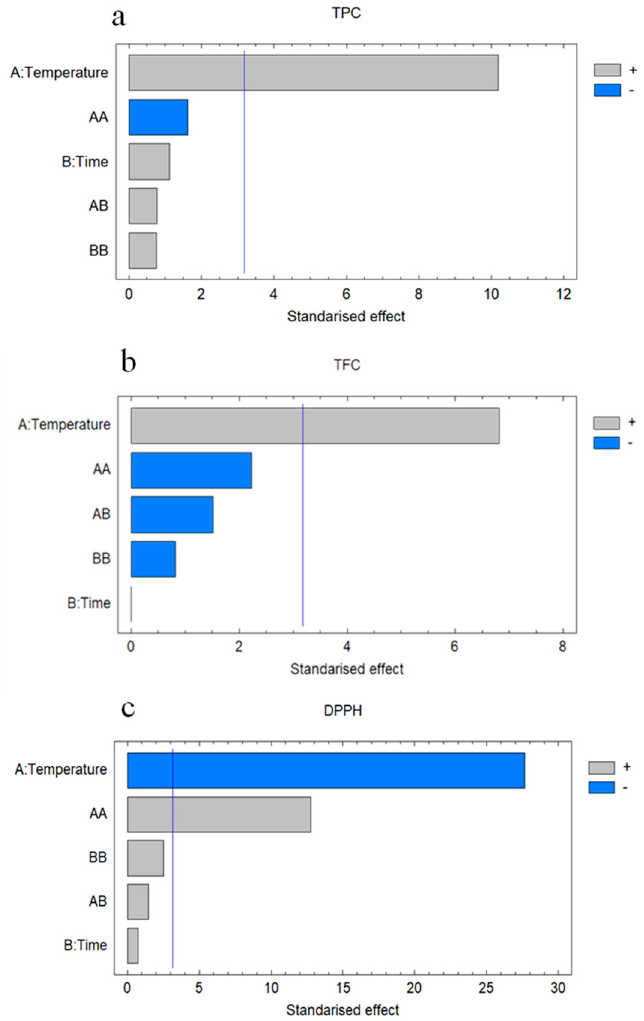
Figure 2. Standardized Pareto diagram for ( a ) TPC, ( b ) TFC, and ( c )